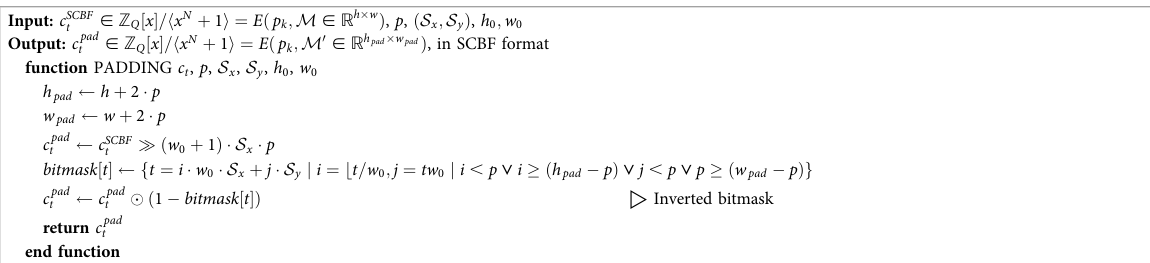
Algorithm 2 Streamlined 2D Padding Input: c SCBF